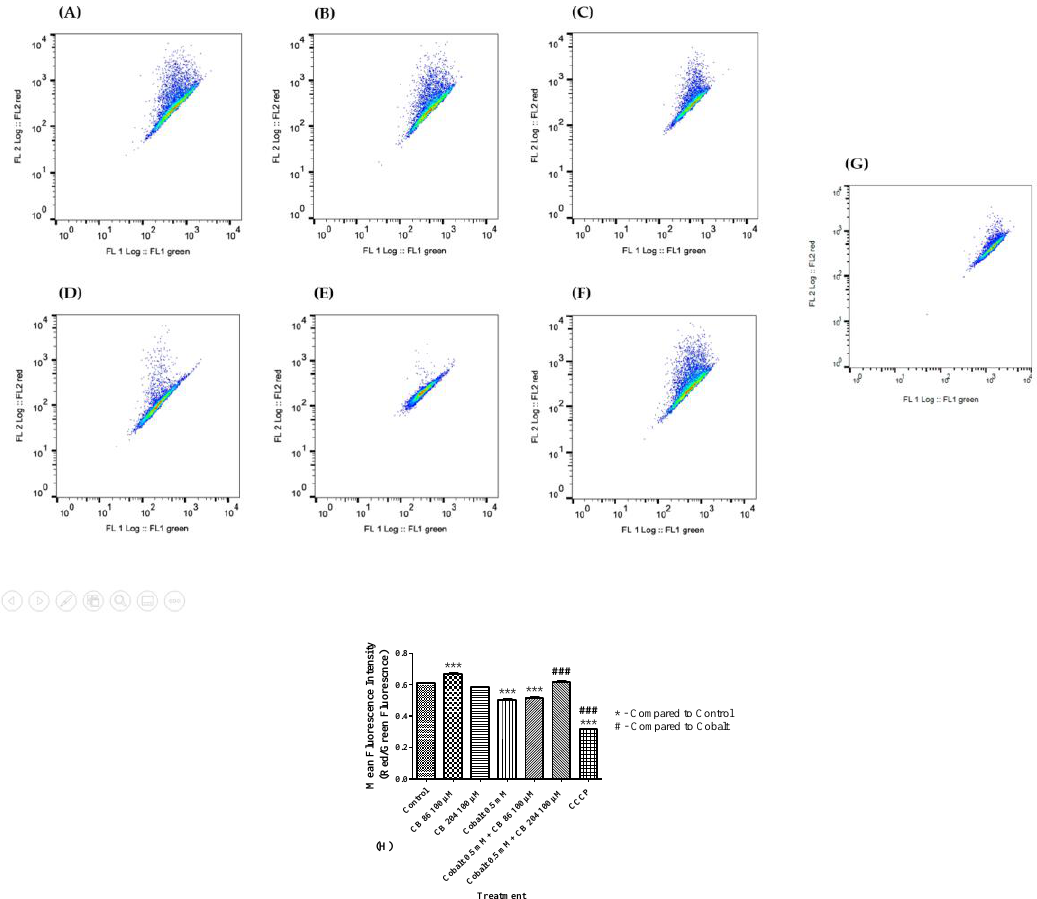
Figure 5. Comparison of the protective capacities of CB86 and CB204 in prevention of mitochondrial membrane potential depolarization. FACS was used to evaluate the ∆ ψ m depolarization in ( A ) Control group, ( B ) cells pretreated with CB86 alone, ( C ) cells pretreated with CB204 alone, ( D ) cells exposed to 0.5 mM of CoCl 2 , ( E ) cells pretreated with CB86 and exposed to CoCl 2 , ( F ) cells pretreated with CB204 and exposed to CoCl 2 , ( G ) positive control group exposed to CCCP, and ( H ) representative bar graph of the raw data. Results are expressed as mean ± SEM ( n = 7 replicates in each group). ### and *** p < 0.001.